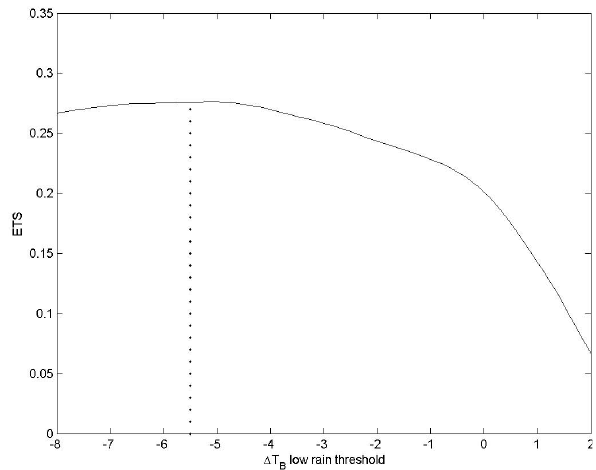
Fig. 6. Equitable Threat Score (ETS) as a function of the 1 T B threshold (K) utilized for delineating the precipitating areas (RR > 0) for all AMSU observations of the case study.